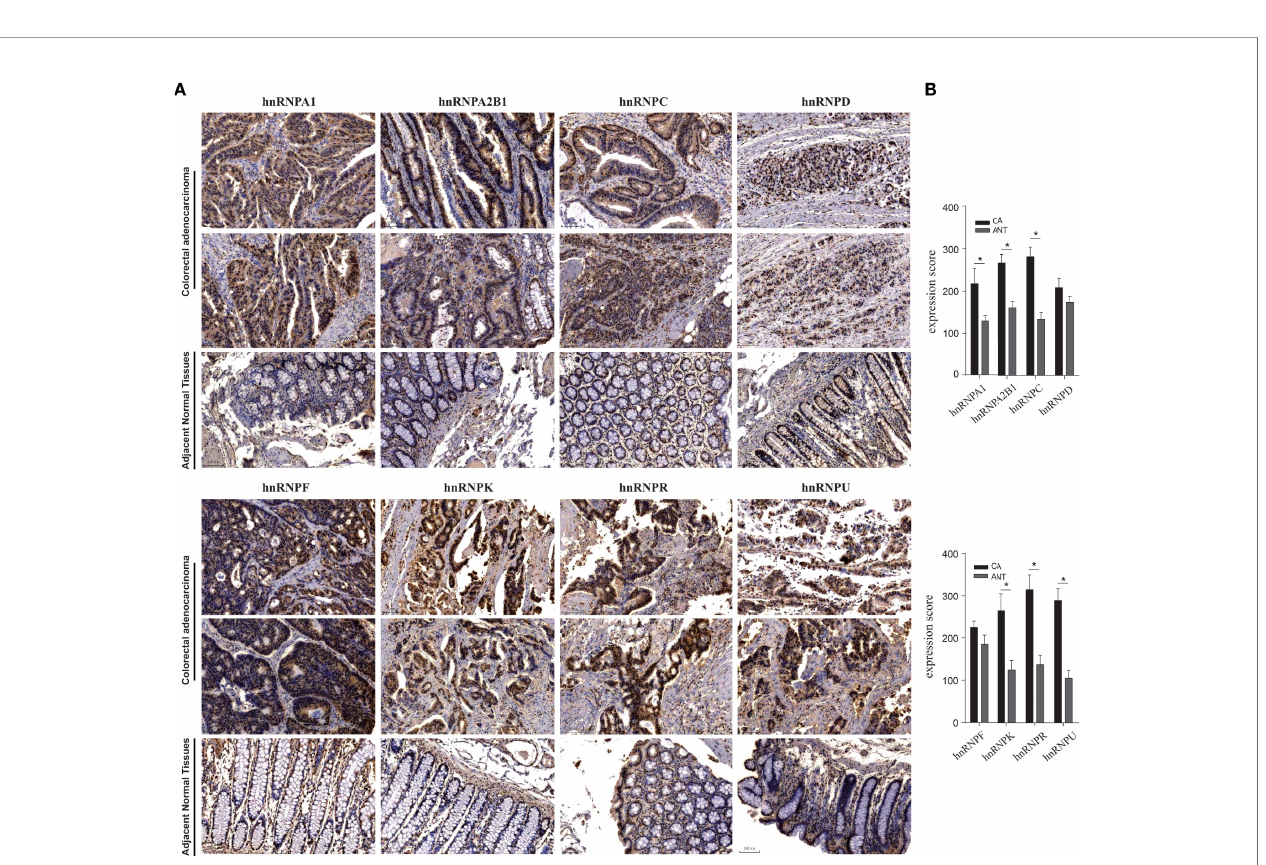
FIGURE 2 | IHC staining of hnRNPs family members in 10 human colorectal adenocarcinoma specimens. By using IHC staining of 10 human colorectal adenocarcinoma specimens, we con fi rmed that hnRNPA1, hnRNPA2B1, hnRNPC, hnRNPK, hnRNPR, and hnRNPU were mainly localized in the nucleus and had higher expressions in colorectal adenocarcinoma tissues compared with adjacent normal tissues (ANT). * P < 0.05.